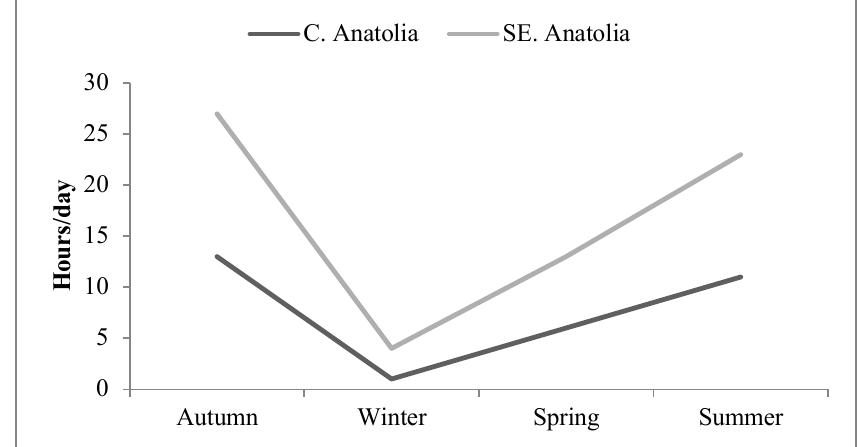
Figure 1. Daily hours spent in agricultural fields by C. and SE Anatolian women during the